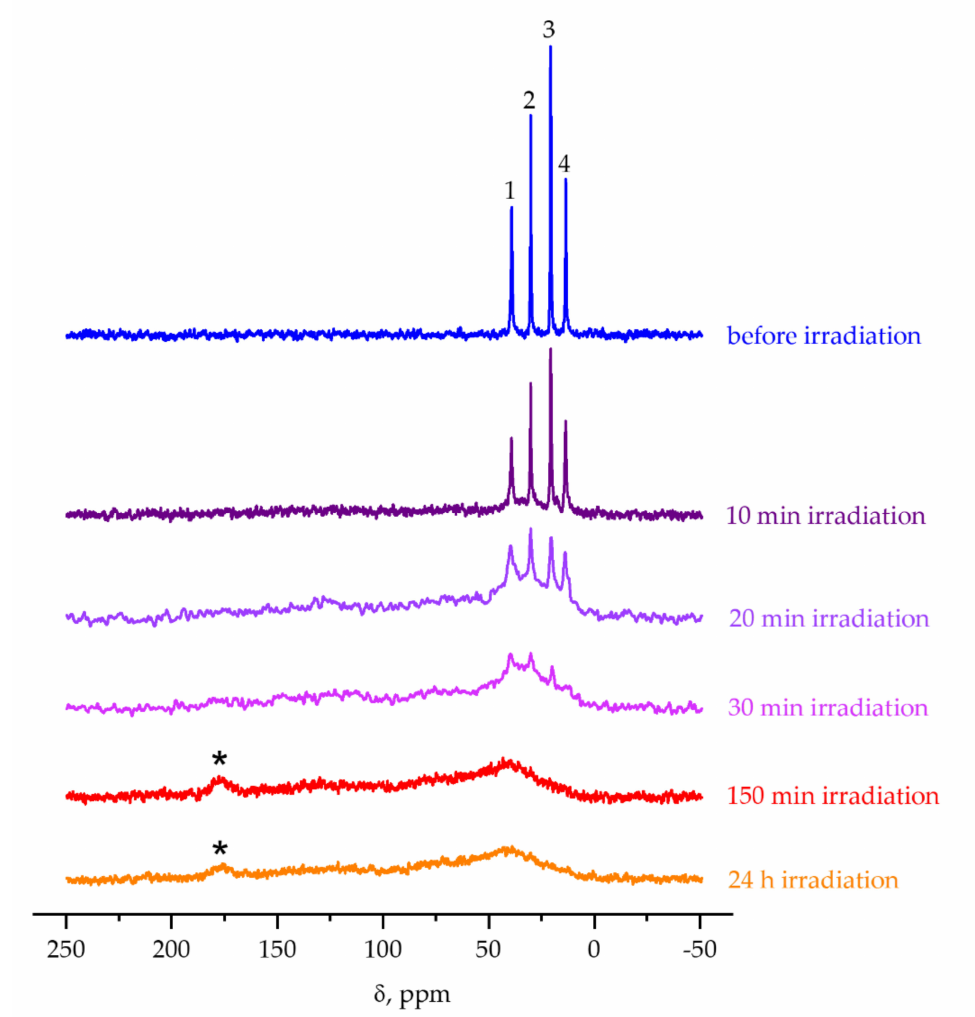
Figure 3. 13 C solid-state NMR spectra of the n -butylamine-intercalated titanate HLT 3 × BuNH 2 after different times of irradiation in 1 mol. % aqueous methanol solution with H 2 PtCl 6 additive (standard photocatalytic conditions); 1, 2, 3, 4–characteristic peaks of n -butylammonium, *—new peak corresponding to carbon in oxidized